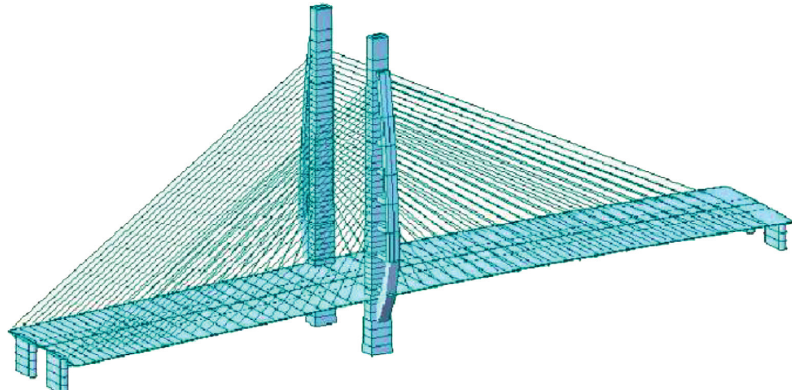
Figure 2: The finite element model of Nanfeihe Bridge structure.